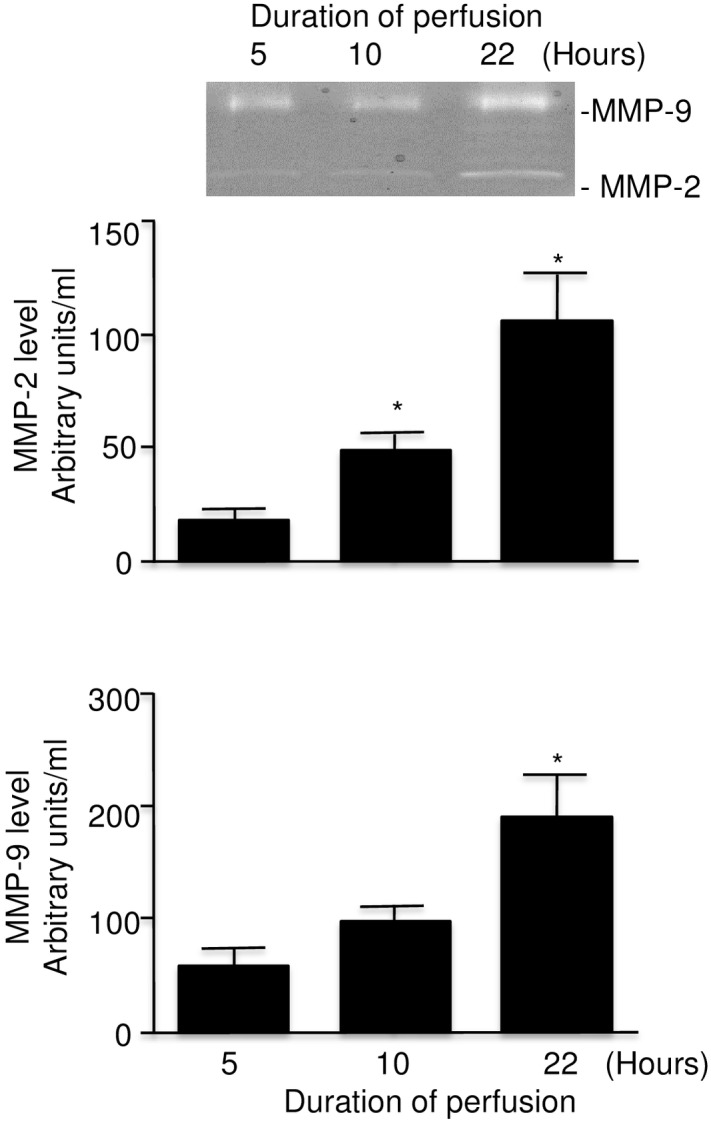
Comparison of MMP-9 and MMP-2 levels at 5, 10, and 22 hours in perfusates from rat kidney with warm ischemic injury undergoing machine cold perfusion (n = 7).Insert: representative zymography with MMP-9 and MMP-2 activitiesError bars represent Standard Error of the Mean (SEM). * p<0.05 compared to 5 hours using Student’s T test.